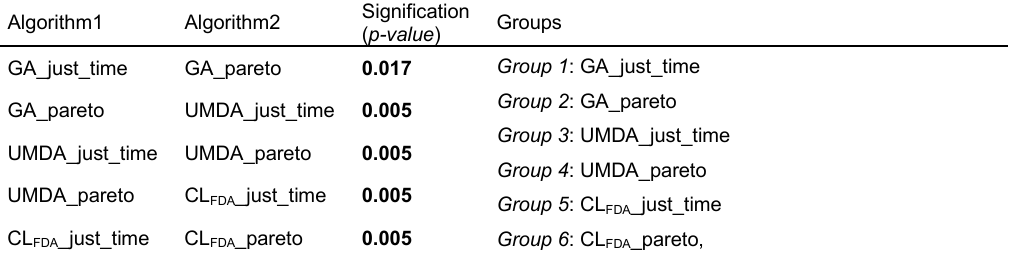
Table 8. Comparison results using Wilcoxon test, variable Execution_time (j30_17 dataset)